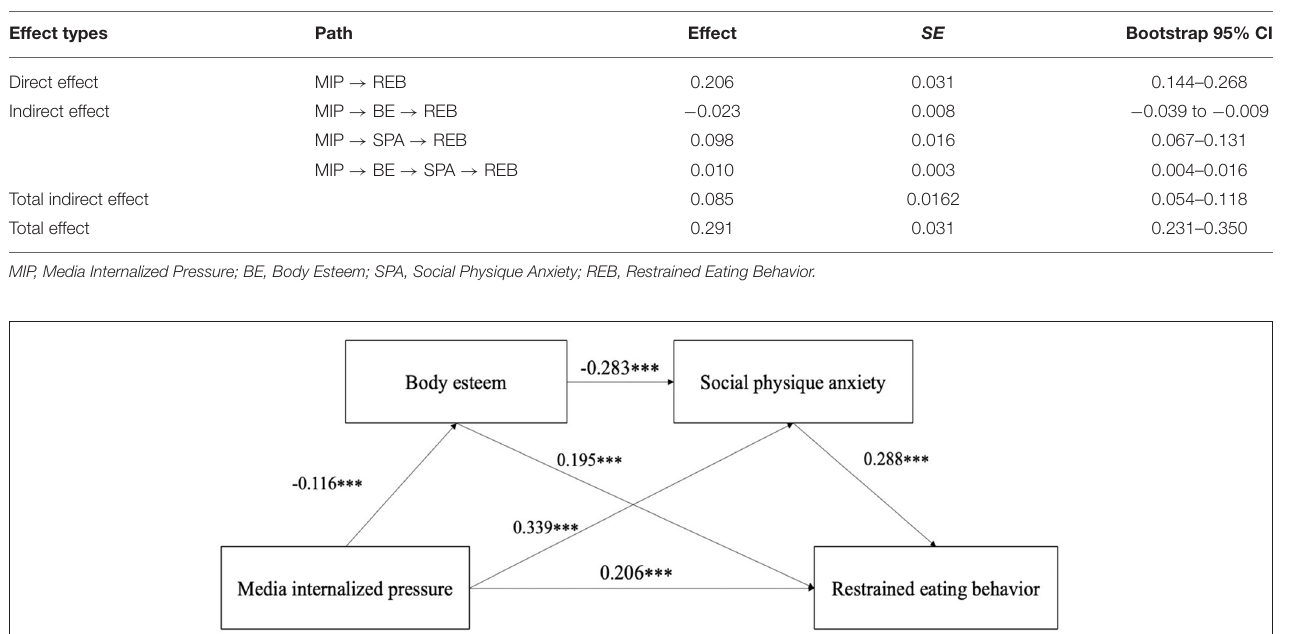
TABLE 4 | Bootstrap analysis of the test for mediating effects ( n = 1,032).